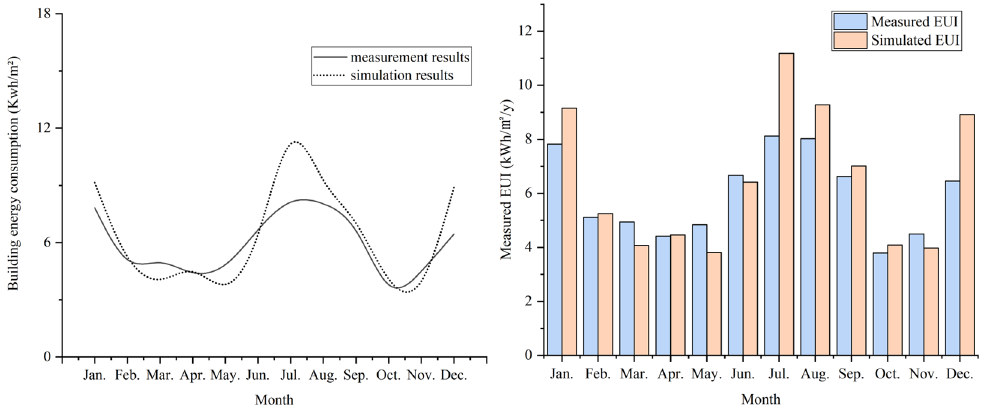
Figure 10. Comparison of measured and simulated EUI.